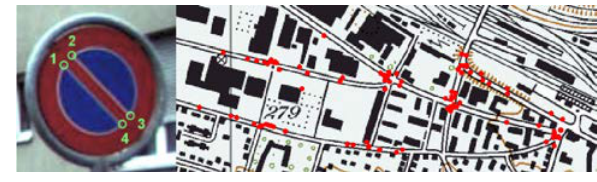
Figure 2. Distribution of check points